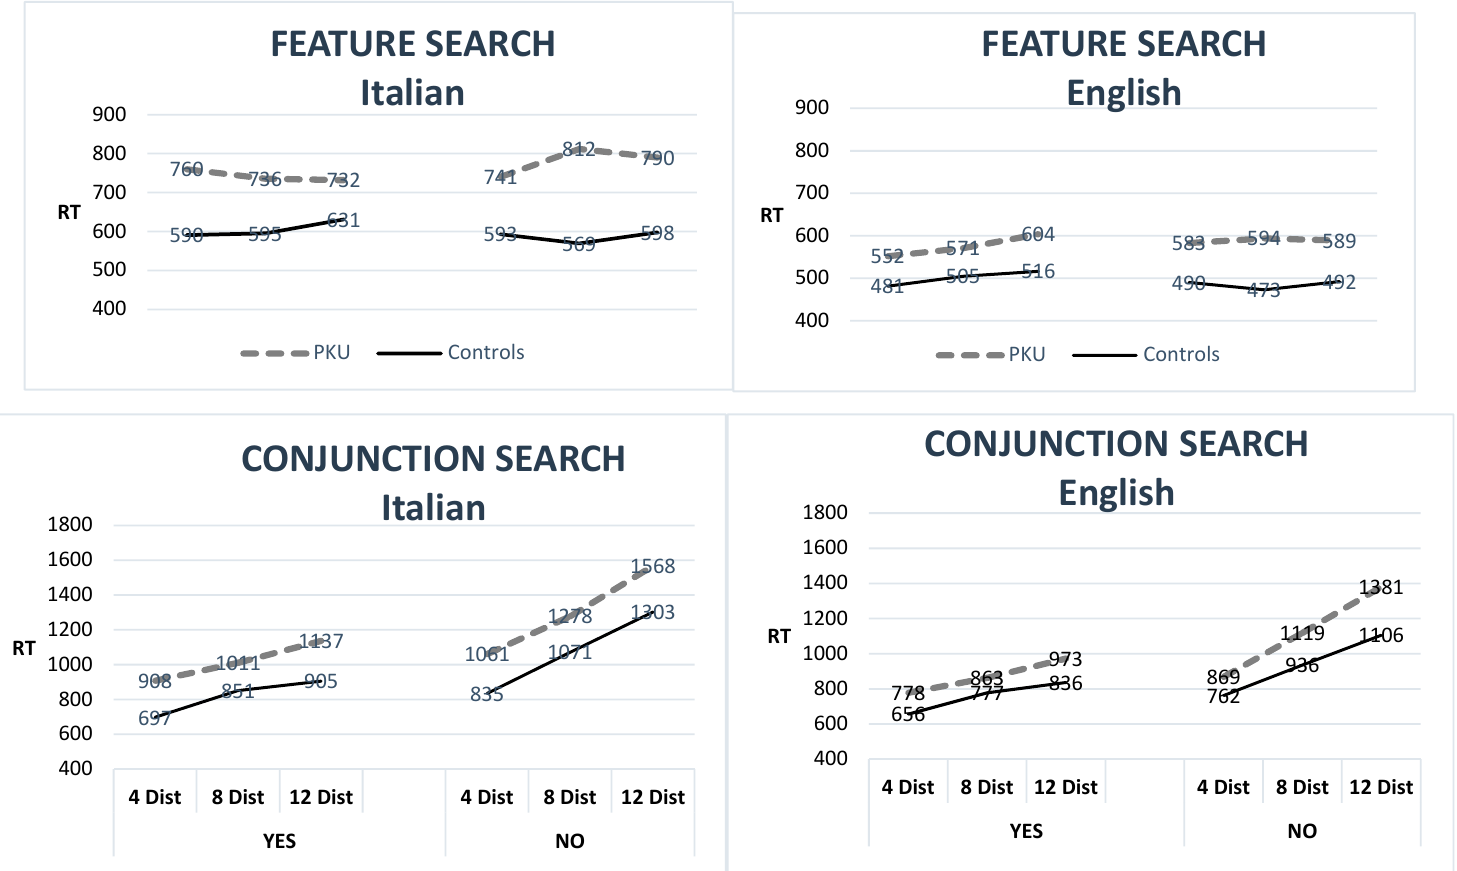
Figure 1. Performance of the UK and Italian PKU groups and relative control groups on the visual search tasks. Dist: distractors, PKU: Phenylketonuria, RT: reaction